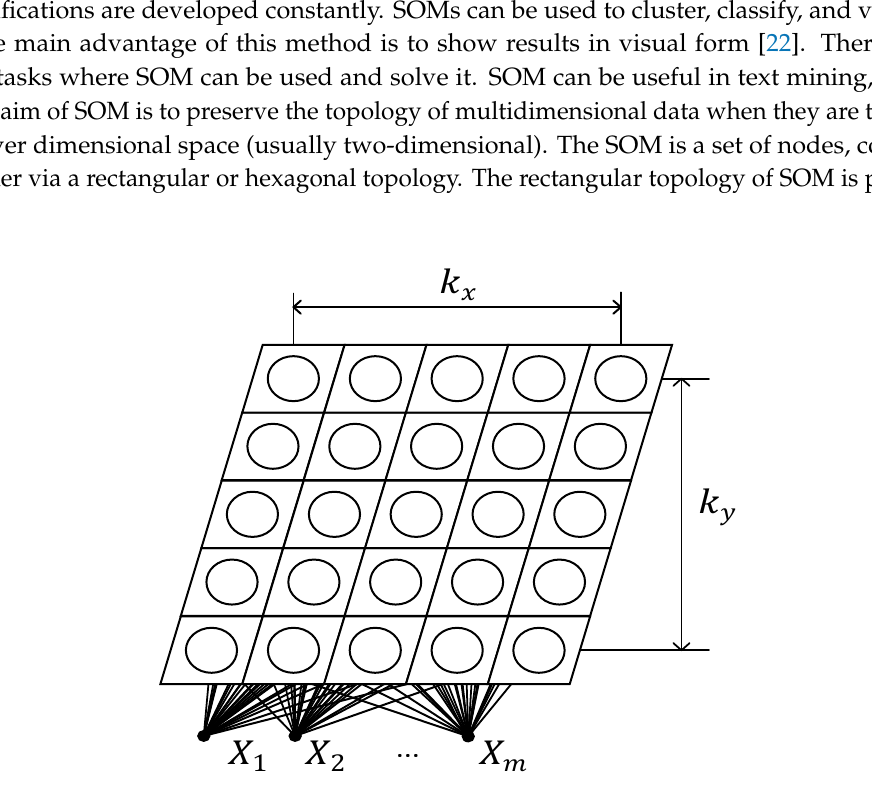
Figure 3. Two-dimensional self-organizing map (SOM) (rectangular topology).